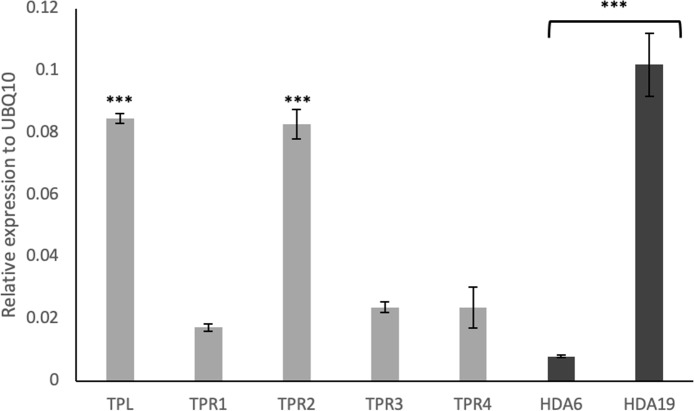
Expression of TPL, TPRs and HDAs genes in the gynoecium.Expression analysis using qRT-PCR in wild-type gynoecia showed that TPL and TPR2 are more strongly expressed than TPR1,3 and 4. Likewise, HDA19 exhibits higher expression compared to HDA6. ***p-values<0.0001; Shown are mean ± standard deviation of three biological replicates. See Figure 4—source data 1 for statistical analyses.